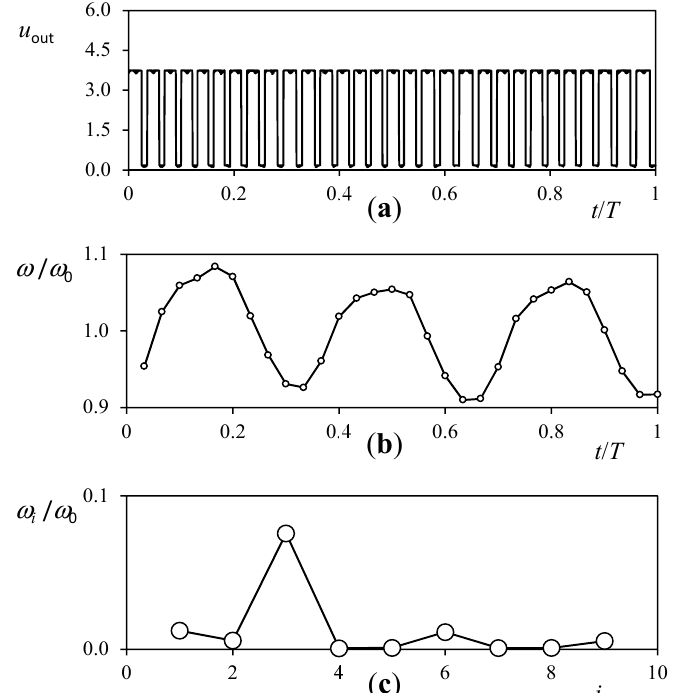
Figure 6. Voltage output signal, u out , from a Climatronics 100075 cup anemometer ( a ). The rotation rate derived from that signal is included in the ( b ) graph, whereas the Fourier series extracted from the rotation rate is included in the ( c ) graph, where the harmonic terms, ω i / ω 0 , are compared (see also Equation (5)).